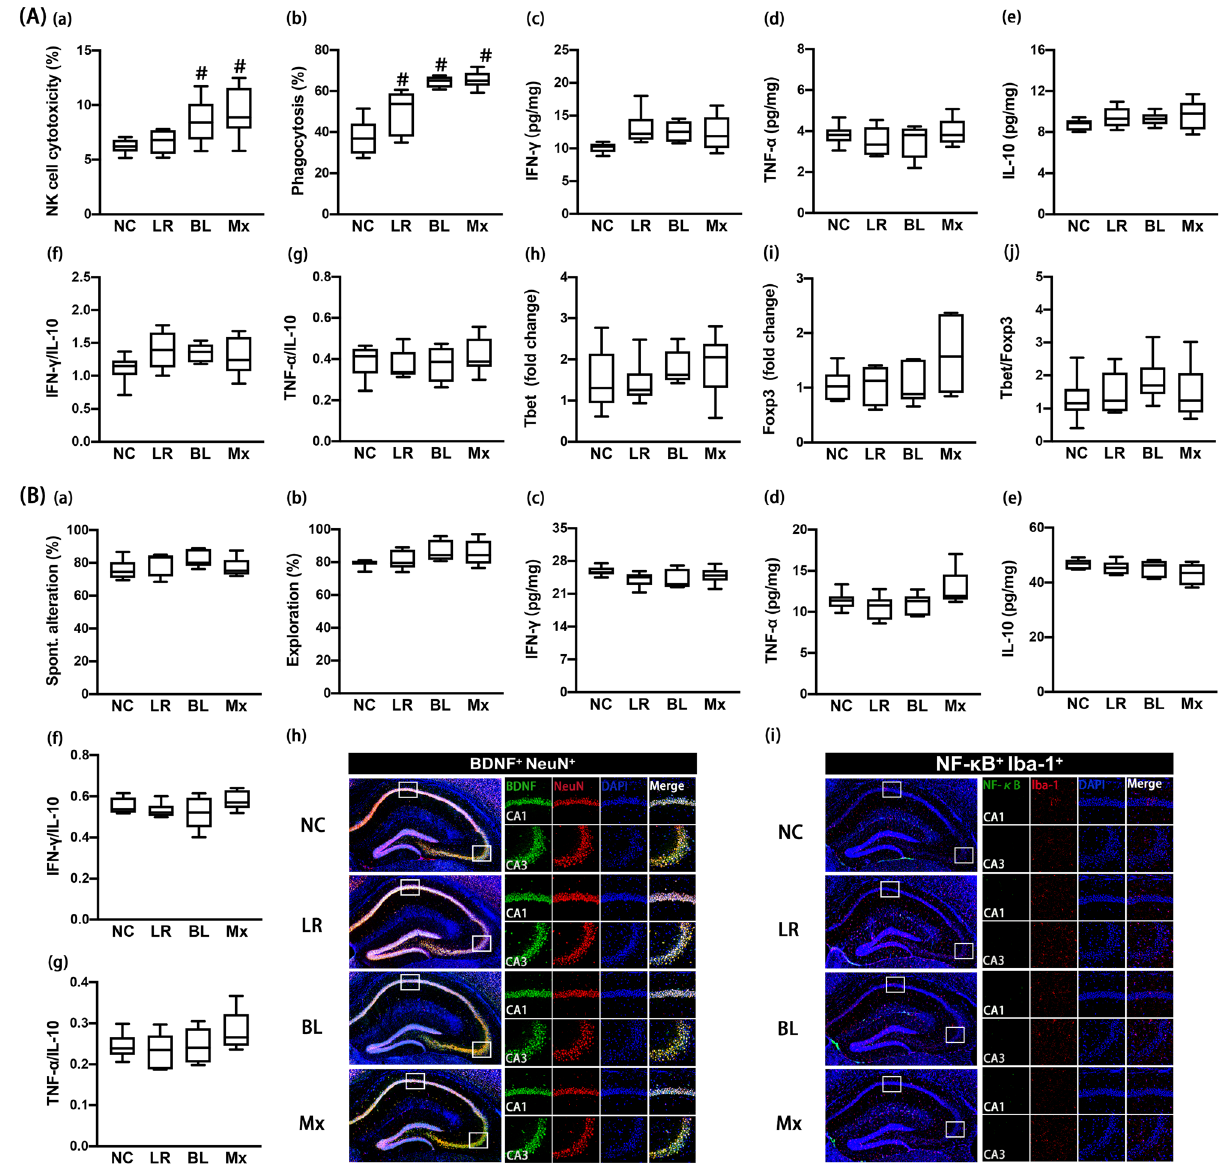
Figure 7. Effects of NK210 and NK219 on systemic immune response and cognitive function in mice. ( A ) Effects on the immune imbalance: splenic NK cell cytotoxicity activities (a), peritoneal macrophage phagocytosis (b), IFN-γ (c), TNF-α (d), and IL-10 expression (e), IFN-γ to IL-10 expression ratio (f), TNF-α to IL-10 expression ratio (g), Tbet (h) and Foxp3 expression (i), and Tbet to Foxp3 expression ratio (j) in the spleen. ( B ) Effects on cognitive impairment in the Y-maze (a) and NOR task (b). Effects on neuroinflammation: IFN-γ (c), TNF-α (d), IL-10 expression (e), IFN-γ to IL-10 expression ratio (f), TNF-α to IL-10 expression ratio (g), and BDNF + /NeuN + (h) and NF-κB + /Iab1 + cell populations (i) in the hippocampus. NK210 (LR, 1 × 10 9 CFU/mouse/day), NK210 (BL, 1 × 10 9 CFU/mouse/day) or their mix (Mx, 1 × 10 9 CFU/mouse/day of LR and BL [4:1] mix) were orally gavaged daily for 5 days. Normal control mice (NC) were treated with vehicle (saline) instead of test agents. Data values indicate mean ± SD (n = 8). # p < 0.05 versus NC